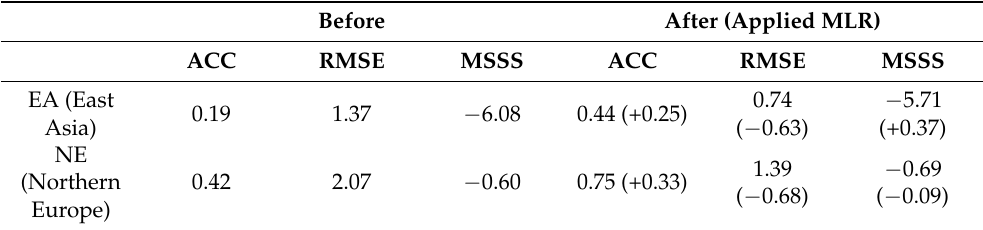
Table 4. Correlation coefficients for the GloSea5 model (before) and applied MLR of the GloSea5 model (after) (compared to the ERA5) in East Asia and Northern Europe. Before After (Applied MLR) ACC RMSE MSSS ACC RMSE MSSS EA (East 0.19 1.37 − Asia)